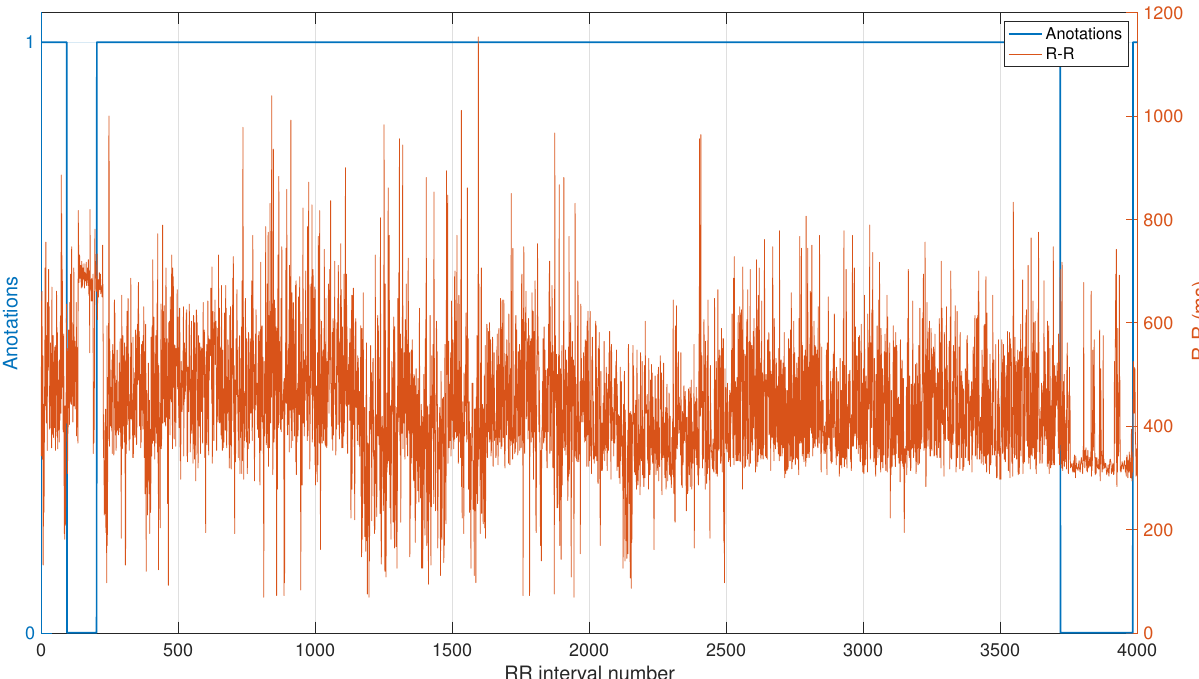
Figure 1. Illustration of AF detection algorithm, showing annotations, and R-R intervals series. An annotation value of 1 signifies the presence of AF while an annotation value of 0 signifies normal